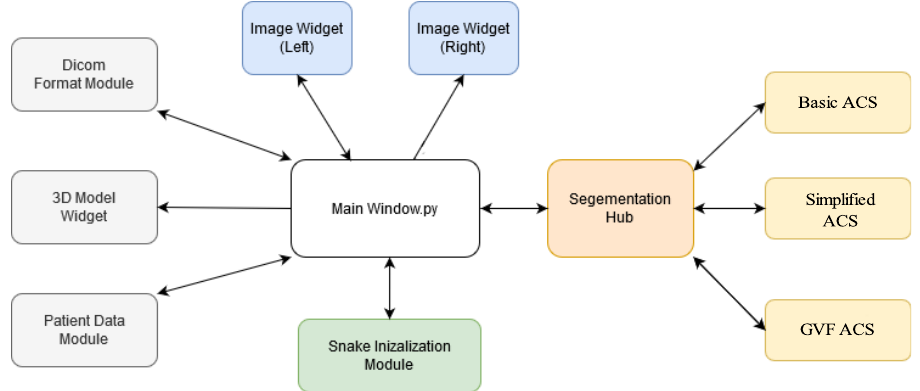
Figure 4. Main software components of the proposed tool. The Segmentation-Hub module can be extended with new modules